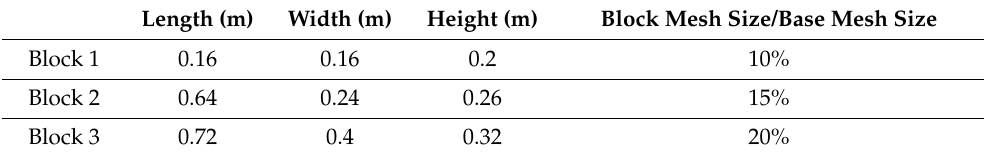
Table 1. Block size and size